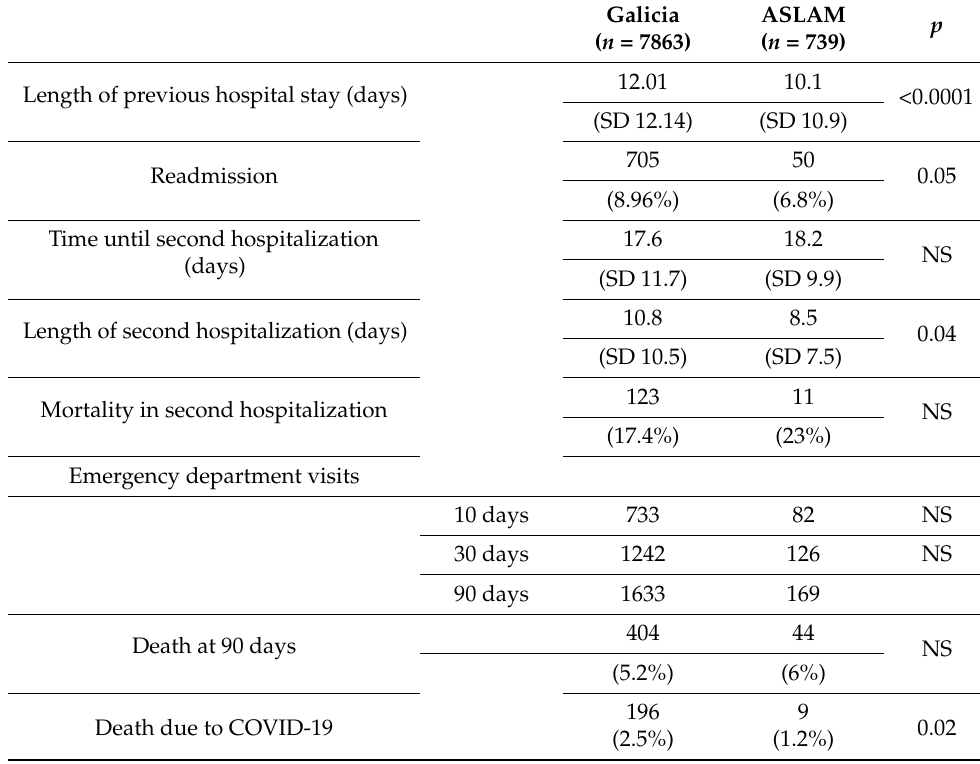
Table 3. Evolution of discharges from ASLAM and the rest of Galicia.